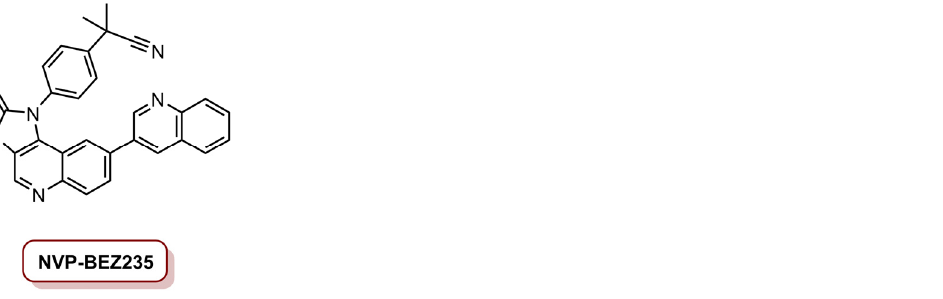
Figure 8. Structure of the dual PI3K-mammalian target of rapamycin (mTOR) inhibitor